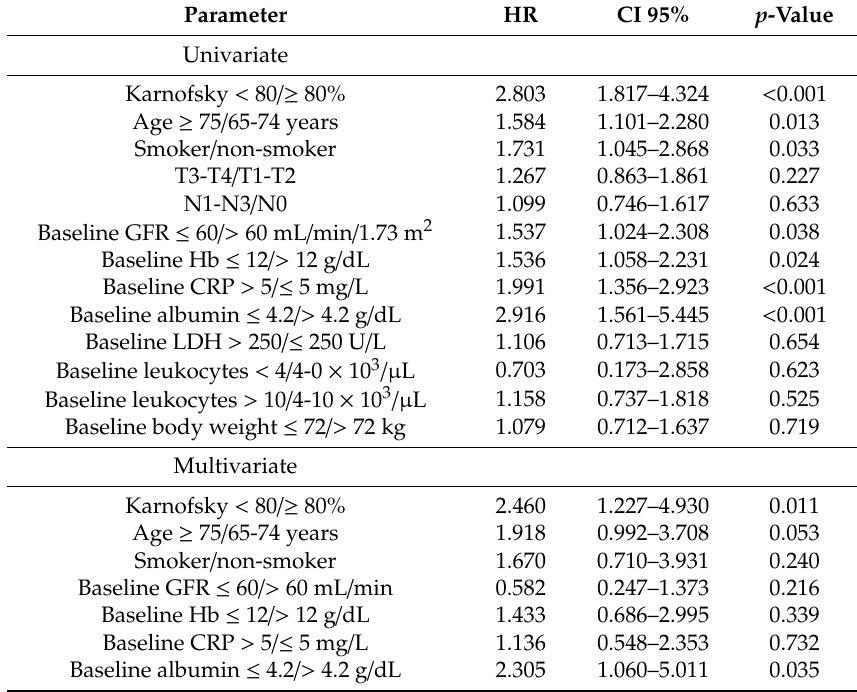
Table 2. Univariate and multivariate analyses of clinical factors and blood parameters at baseline regarding OS in elderly HNSCC patients receiving radiotherapy or chemoradiation ( n =